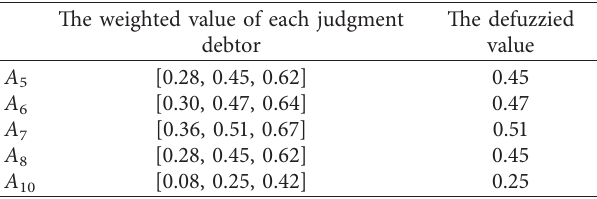
Table 8: The defuzzied value of each judgment debtor in the uncertainty